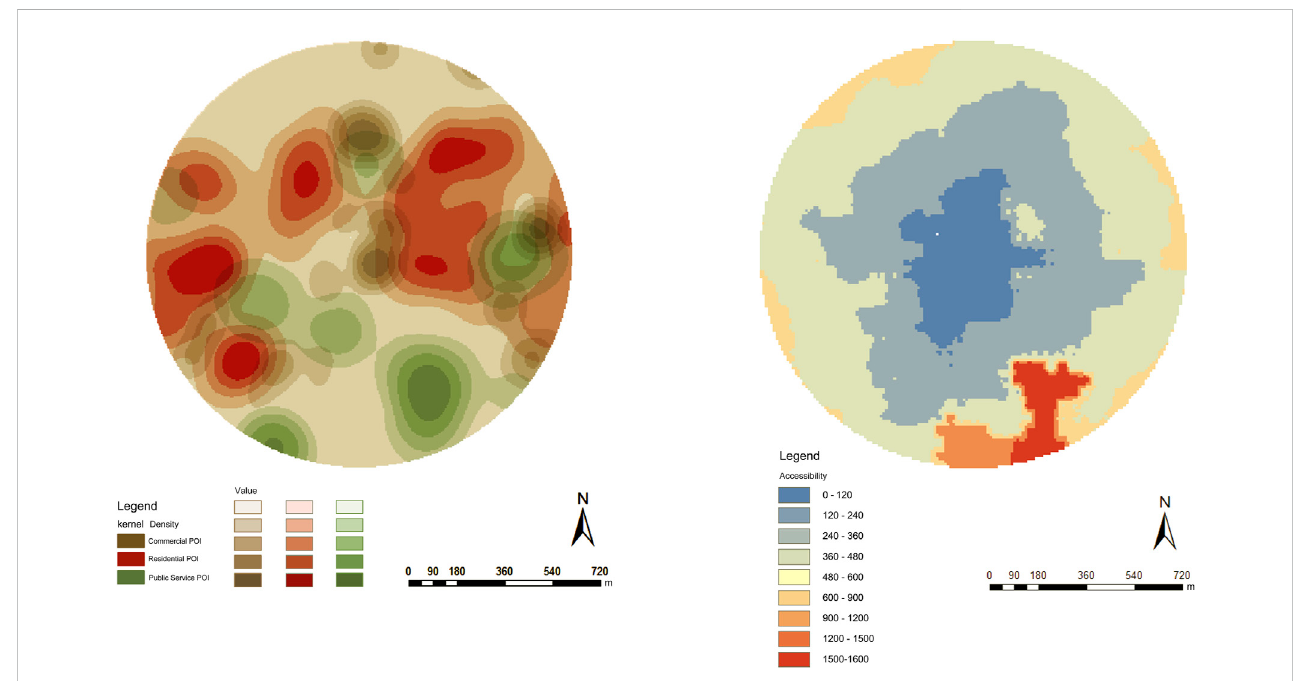
FIGURE 3 Analysis of POI kernel density (left) and accessibility (right) around Zoo Station.